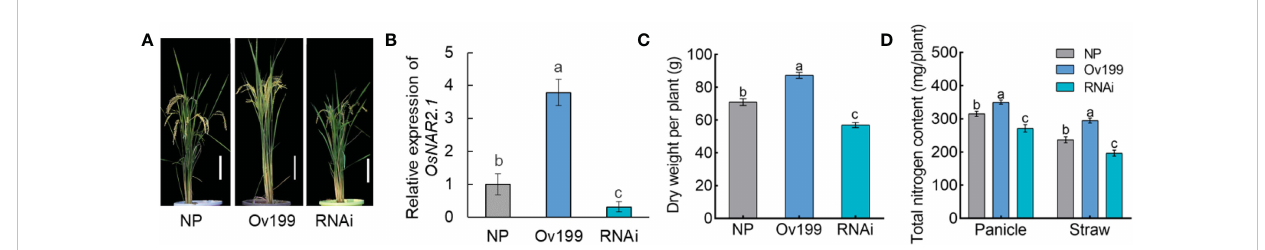
FIGURE 1 Characteristics of phenotype for miRNA sequencing plants. (A) Gross morphology of wild-type of NP, Ov199 and RNAi. Bar, 20 cm. (B) Real-time quantitative RT-PCR analysis of OsNAR2.1 expression in NP, Ov199 and RNAi lines. Dry weight (C) and total nitrogen content (D) of NP, Ov199 and RNAi. Error bars: SD (n = 3). NP, the wild-type of Oryza.Sativa L.spp. Japonica . Ov199, OsNAR2.1 overexpression transgenic line. RNAi, OsNAR2.1 RNAi line. Signi fi cant differences between different lines are indicated by different letters ( P < 0.05, one-way